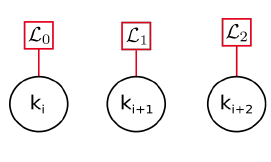
Figure 1: Leakage model with every bit leaking its value independently.